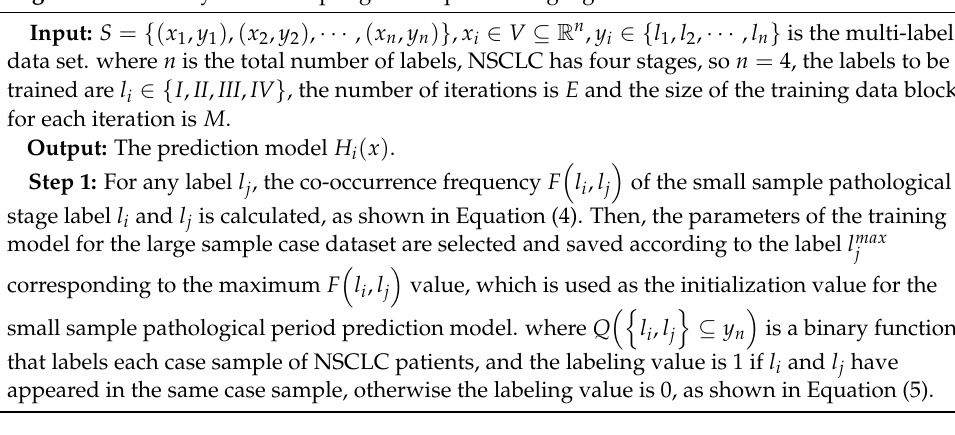
Algorithm 1: The dynamic sampling technique training algorithm